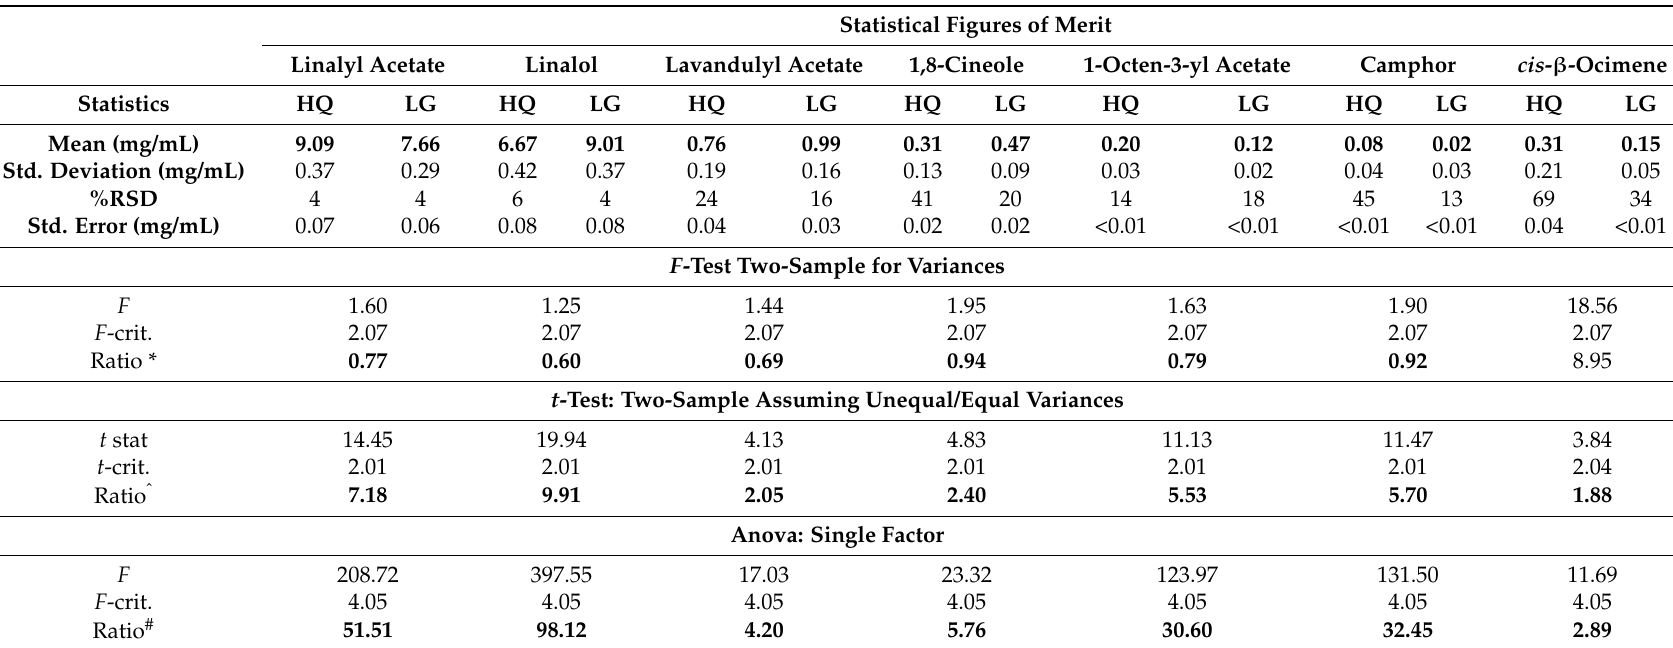
Table 2. Statistical figures of merit for the analyzed high quality and lower grade lavender